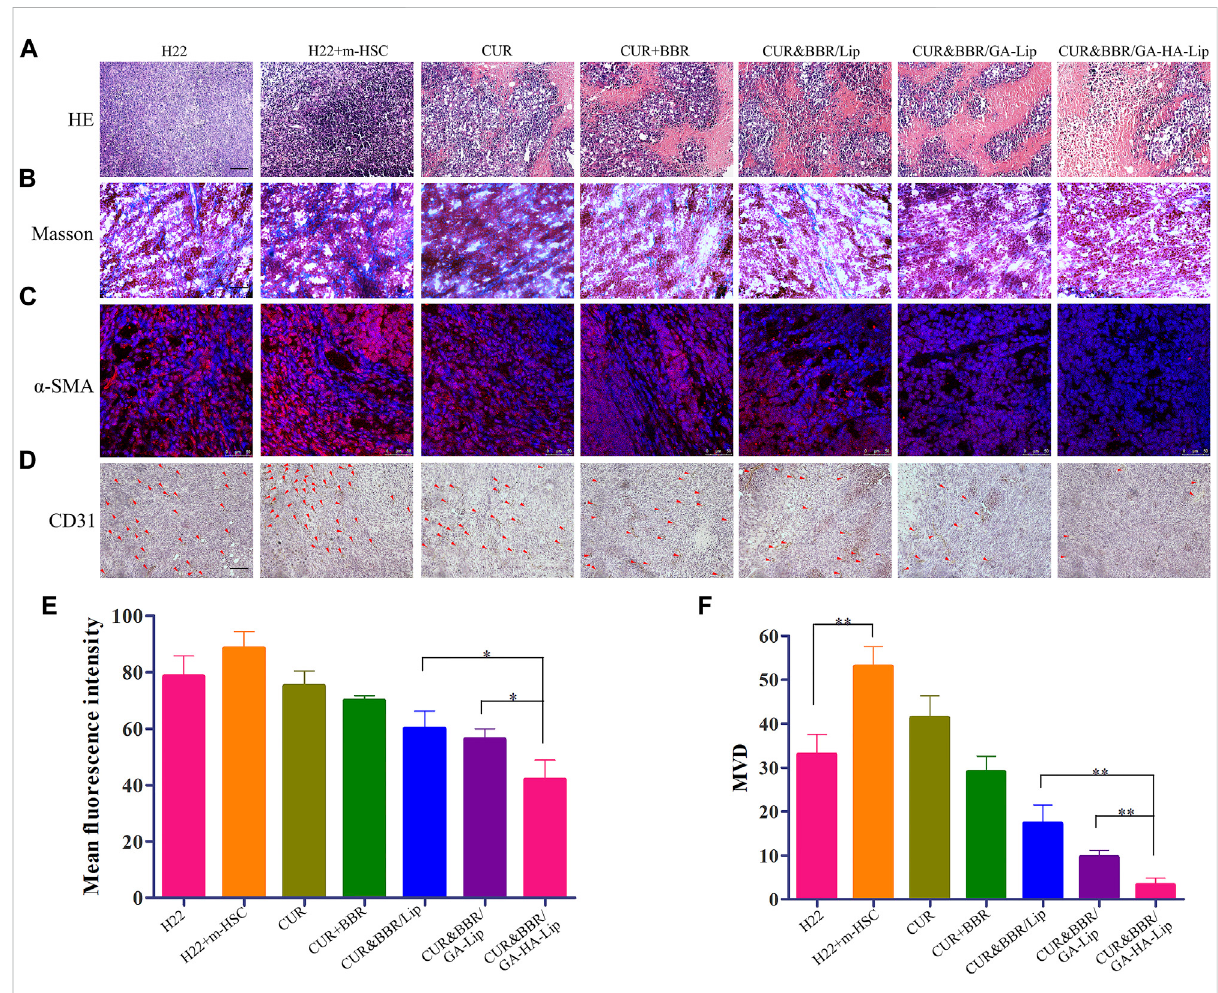
The histological analysis of the H22+m-HSC tumor-bearing mice model. (A) Histological analysis of tumors with H&E staining; scale bars represent 200 µm. (B) Masson stain of tumor tissue; scale bars represent 200 µm. (C) IF staining of α -SMA; scale bars represent 50 µm. (D) IHC staining of CD31; scale bars represent 200 µm. (E) Quantitative analysis of α -SMA and (F)